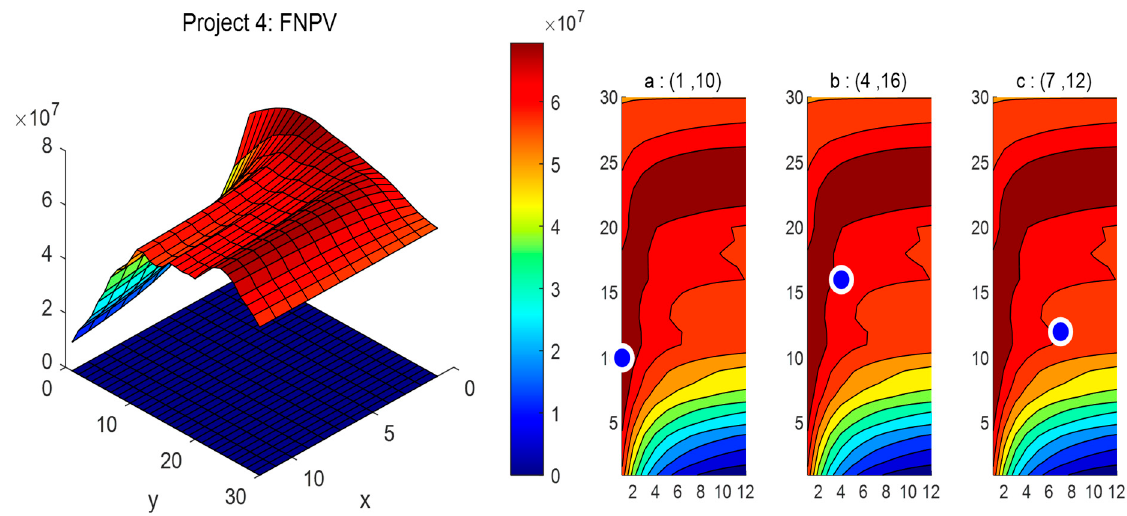
Figure 23. Decision − making for project